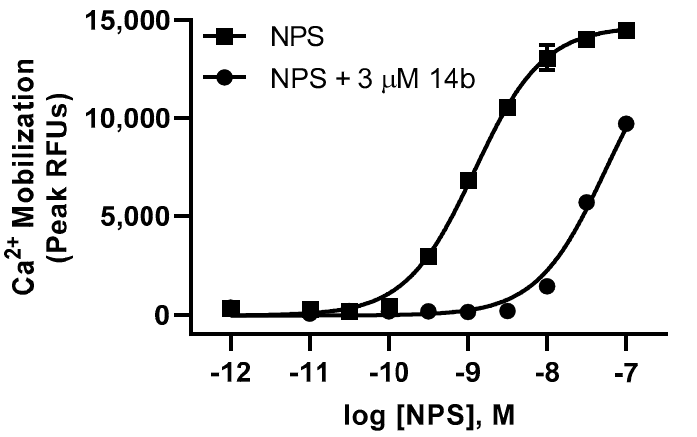
Figure 3. Compound 14b displays a right shift on agonist activity of NPS in calcium mobilization assay (Ke). Table 3. Modifications of urea portion of lead compound